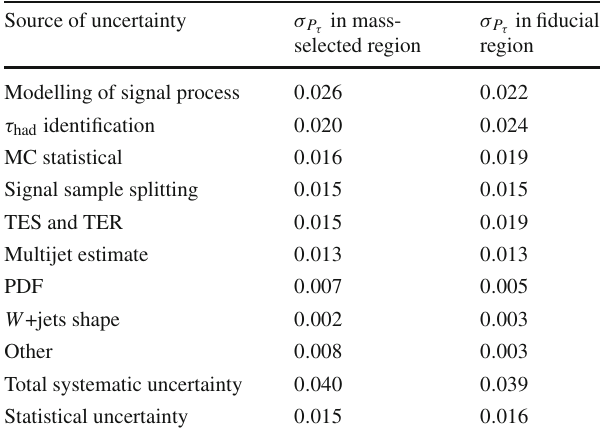
Table7 Impactoftheindividualsourcesofuncertaintyonthepolarisa- tion uncertainty σ P τ in the combined fits that extract the τ polarisation in the mass-selected region of 66 < m Z /γ ∗ < 116 GeV and in the fidu- cial region. The total systematic uncertainty quoted is estimated from the total uncertainty and the statistical